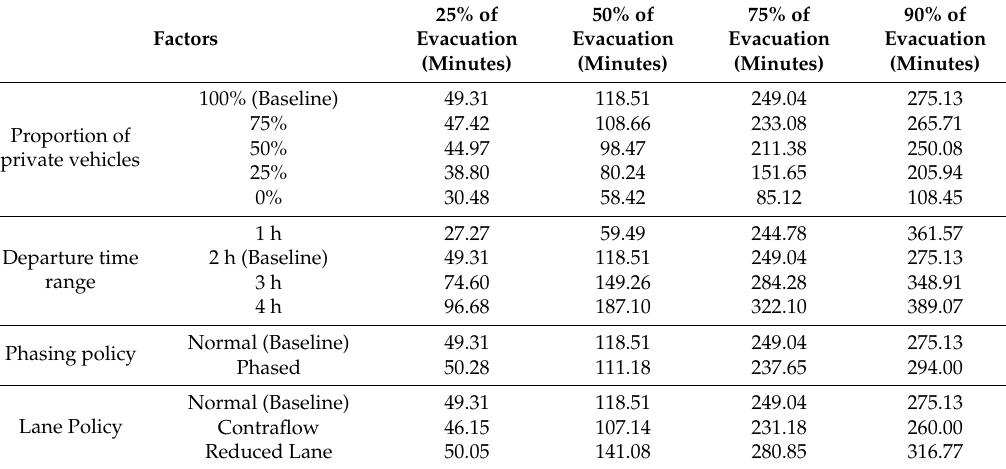
Figure 9. Sensitivity of ( a ) the proportion of private vehicles, ( b ) evacuation departure time period, ( c ) phasing policies, and ( d ) lane policies to clearance rate (%). Table 5. Sensitivity of factors to clearance